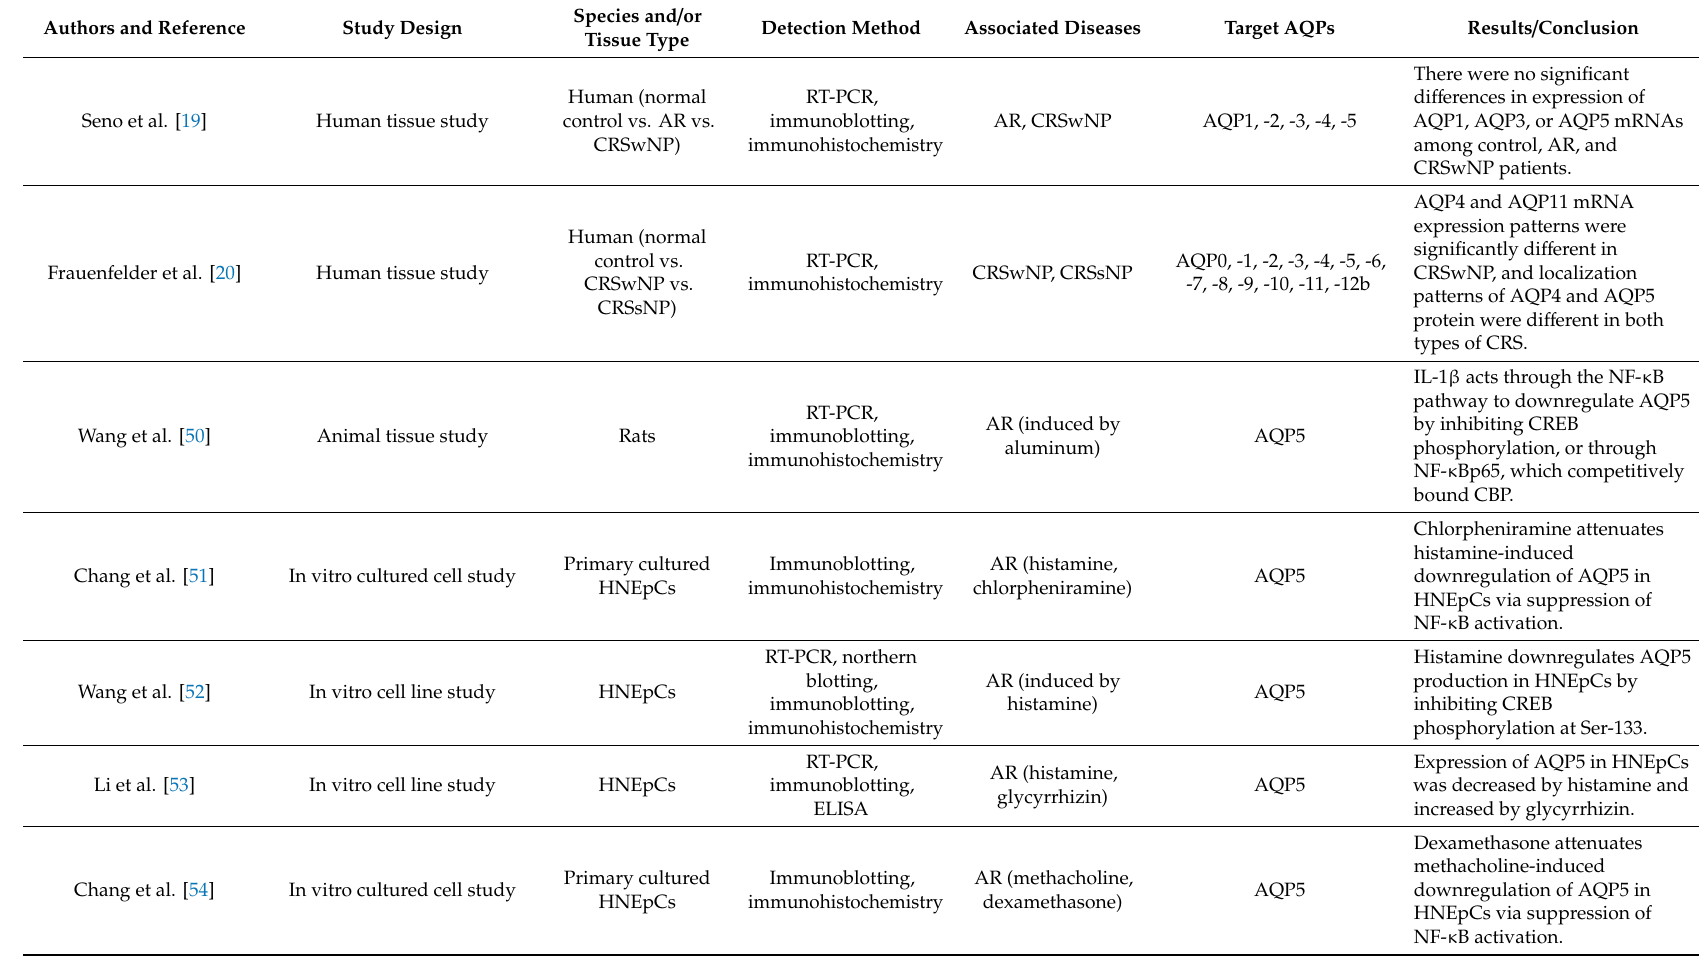
Table 3. Studies assessing the relationship between AQPs and inflammatory diseases in the nasal